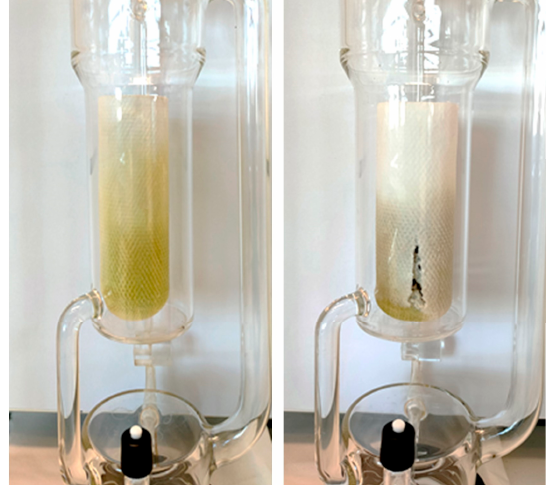
Figure 7. Dry 2-MeOx ( left ) and 2-MeOx 95.5% ( right ) Soxhlet extraction: cellulose cartridges initially filled with the same quantity of OP.